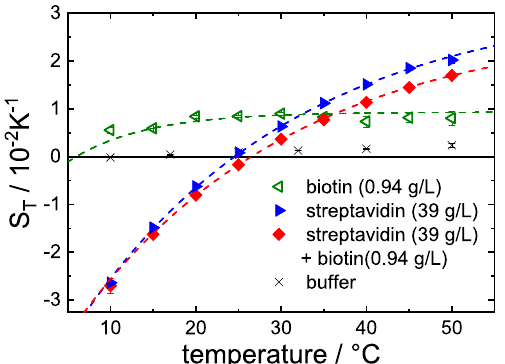
Figure 4. Soret coefficient S T against temperature. Shown are biotin (green), STV (blue) and STV + B (red), all in H 2 O-buffer. The signal of the buffer itself (black crosses) is about one order of magnitude smaller compared to biotin. Note, the slight excess of biotin (cf. Appendix A Table